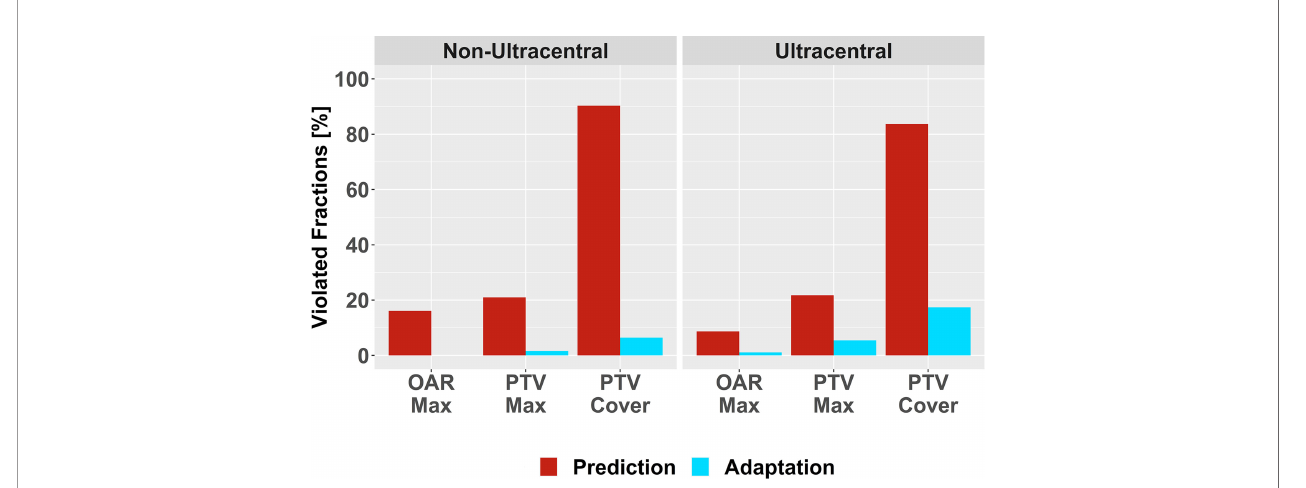
FIGURE 1 | Violation of Planning Objectives. Relative number of violated planning objectives before (red) and after plan adaptation (blue) for non-ultracentral and ultracentral lung tumors: exceeded maximum dose inside organs-at-risk (OAR Max) or inside the planning target volumes (PTV Max); inadequate PTV coverage (PTV